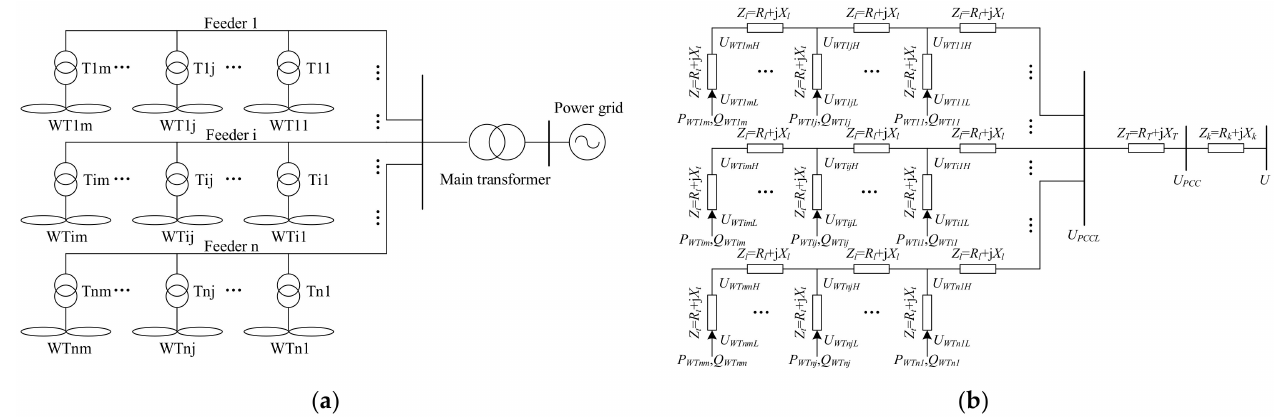
Figure 5. ( a ) Radial structure; ( b ) The equivalent model. The PMSG-based wind farm. Table 3. The impedance values mentioned in Figure 5b. Parameters Values Z t (the equivalent impedances of all WTs’ box-type transformers)/p.u.